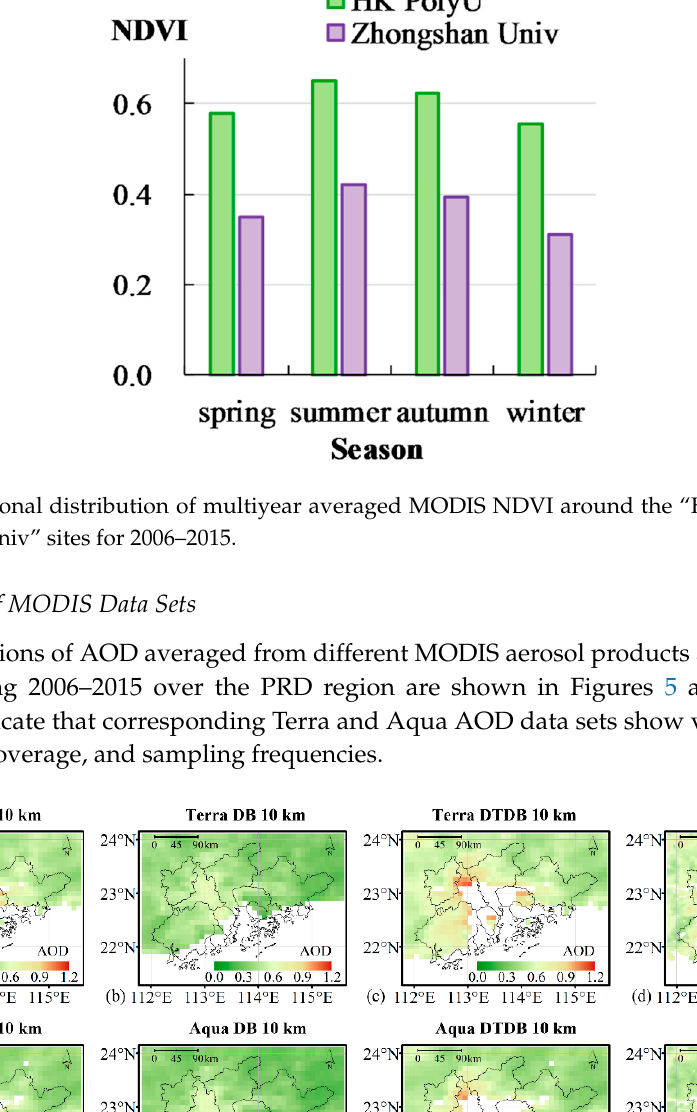
Figure 6. Ten-year (2006–2015) mean sampling frequencies for Terra ( a – d ) and Aqua ( e – h ) MODIS aerosol products. 3.4. Evaluation of the DT/DB Merging Protocol Figure 7 shows the comparison results of the spatial coverage of multiyear mean AOD derived from DT and DB 10 km AOD products. The DB 10 km product provides valid retrievals over highly urbanized areas which are missed by the DT 10 km product. In contrast, the DT 10 km product has better coverage than the DB 10 km product over coastal areas. Thus, if an appropriate merging algorithm is used, it is possible to obtain a data set with reduced-gap coverage by utilizing the strengths of the DT and DB 10 km products. However, Figure 8 indicates that many valid DB 10 km retrievals are excluded in the merging process. Furthermore, comparing Figures 7 and 8 demonstrates that the DTDB 10 km product has similar coverage to the DT 10 km product. Thus, although the merged AOD product is intended to provide a more complete data set than either the DT or DB 10 km products, it does not do so over the PRD region. The protocol used to generate the merged DT/DB AOD product is based on three classifications determined from a climatological NDVI map. If an NDVI ≥ 0.3, then the DT 10 km AOD (QA = 3) is used, and if an NDVI ≤ 0.2, then the DB 10 km AOD (QA = 2 or 3) is used. For intermediate NDVI values, the retrieval with the highest QA value is used, or, if both values exhibit high confidence, the average of the two retrievals is used [7,18]. Figure 9 shows the spatial distributions of the seasonal mean NDVI values derived from the Terra and Aqua MODIS-derived monthly NDVI product for 2006–2015. The NDVI is generally higher than 0.3 over the PRD region, especially in summer and autumn. Therefore, many valid DB 10 km AOD retrievals will not be included in the merged AOD product, even when DT 10 km retrievals are unavailable. In addition, Figure 9 indicates that there are only a small number of pixels with an NDVI value of less than 0.2 over the PRD region throughout